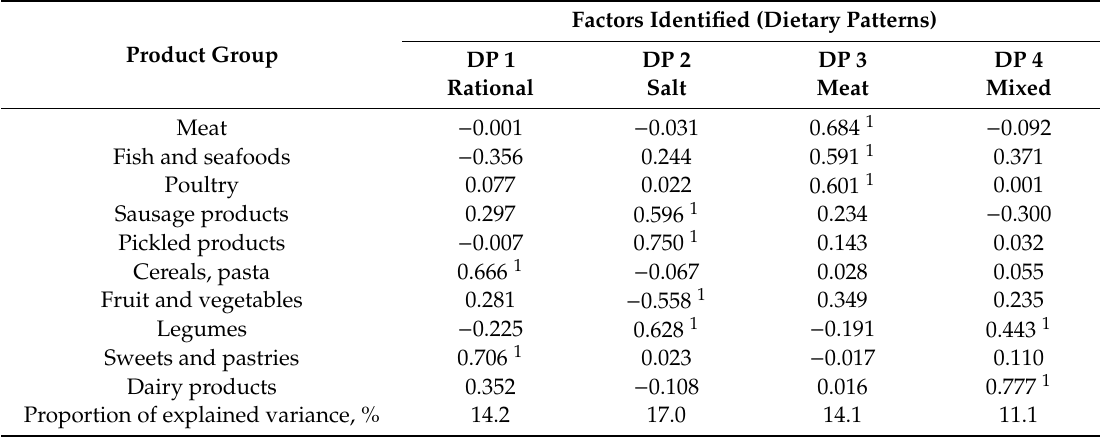
Table A16. Factor loadings of the principal dietary patterns identified (Orenburg region).